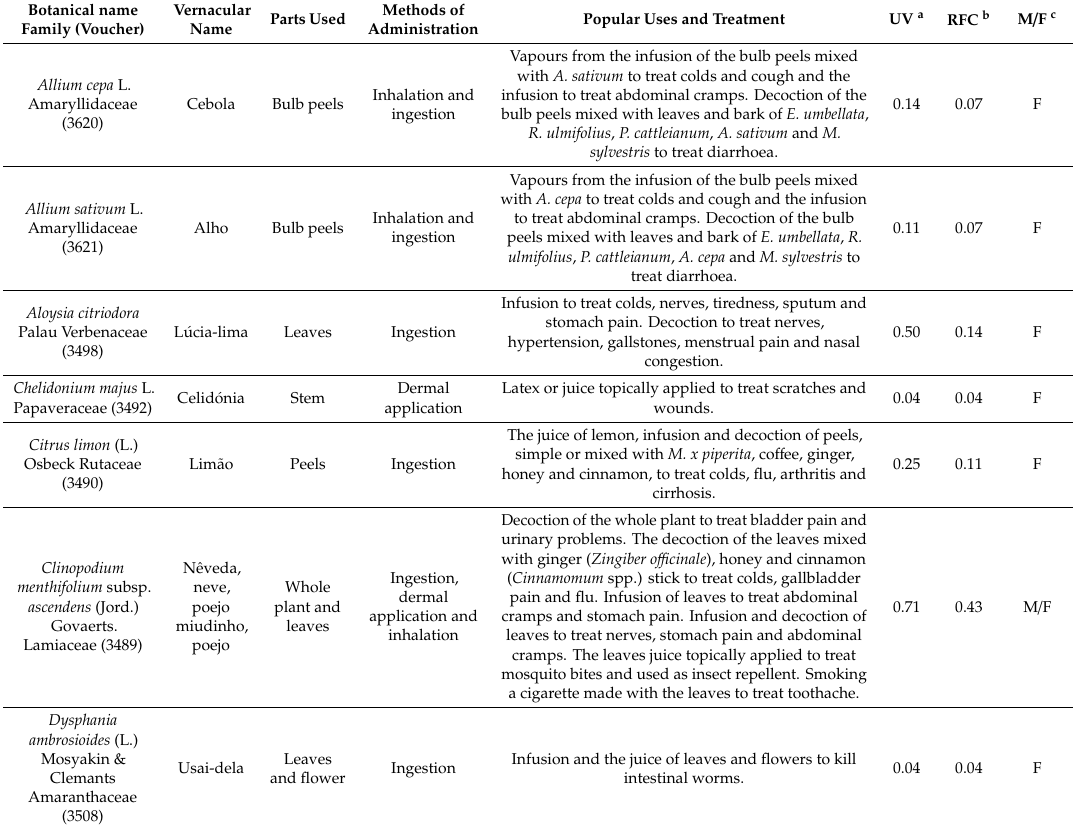
Table 1. Medicinal plants used by the people of the Sete Cidades village.